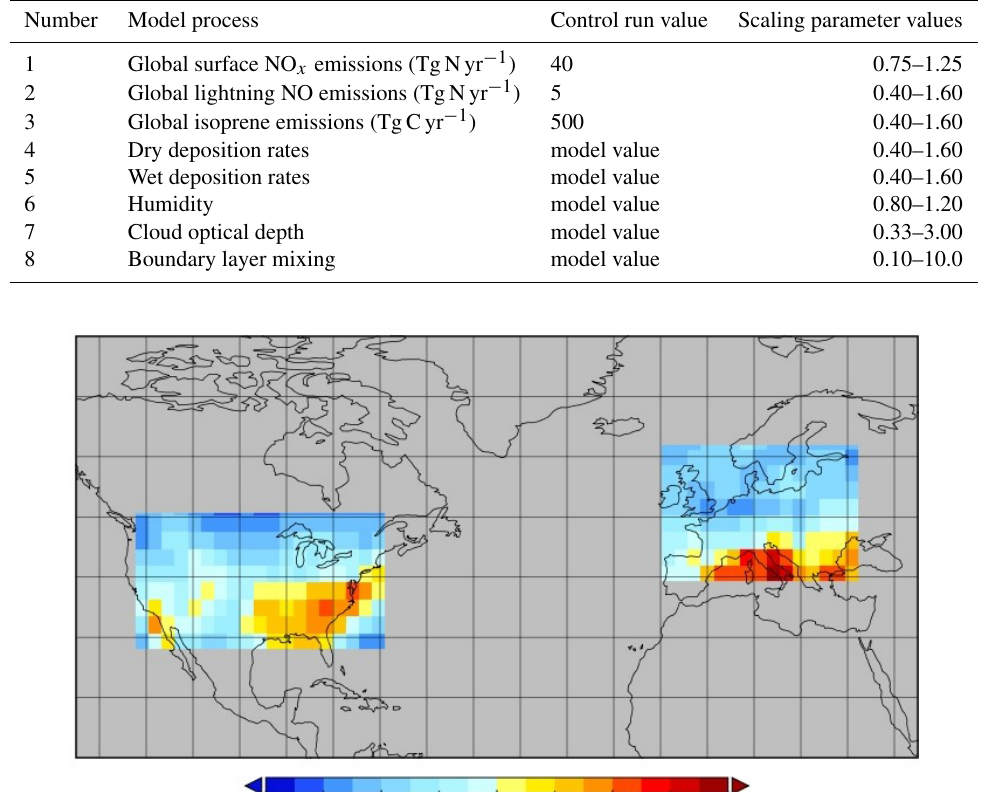
Table 1. Model processes and associated scaling parameter ranges used in this study.